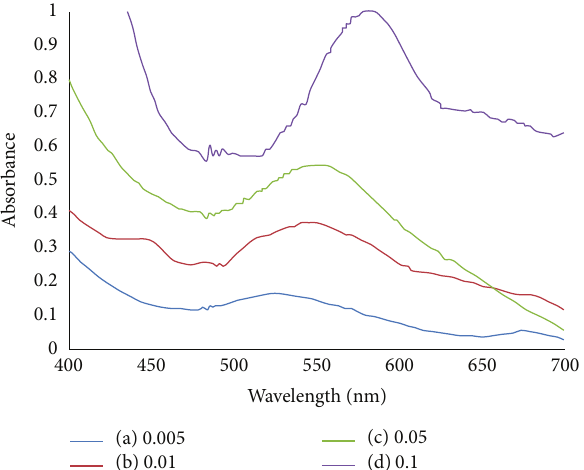
Figure 11: Absorption spectra of chitosan capped AuNPs mixed with different weights of copper oxide: (a) 0.005 g; (b) 0.01g; (c) 0.05 g; (d) 0.1 g.